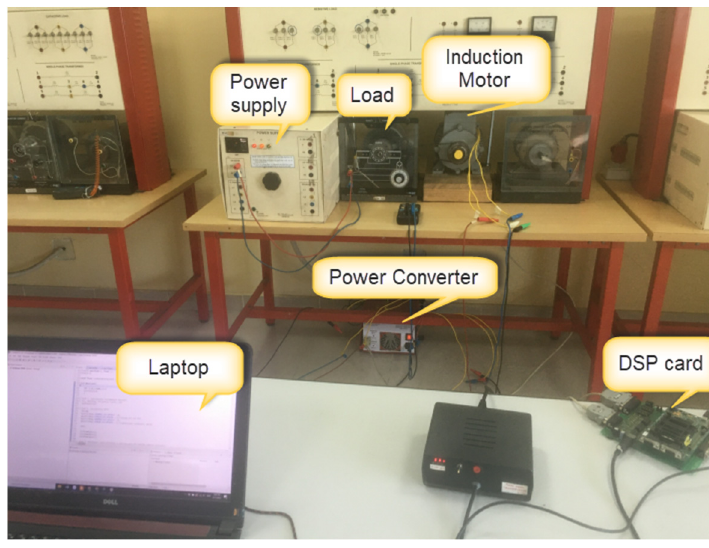
Figure 11. Experimental IMD model.